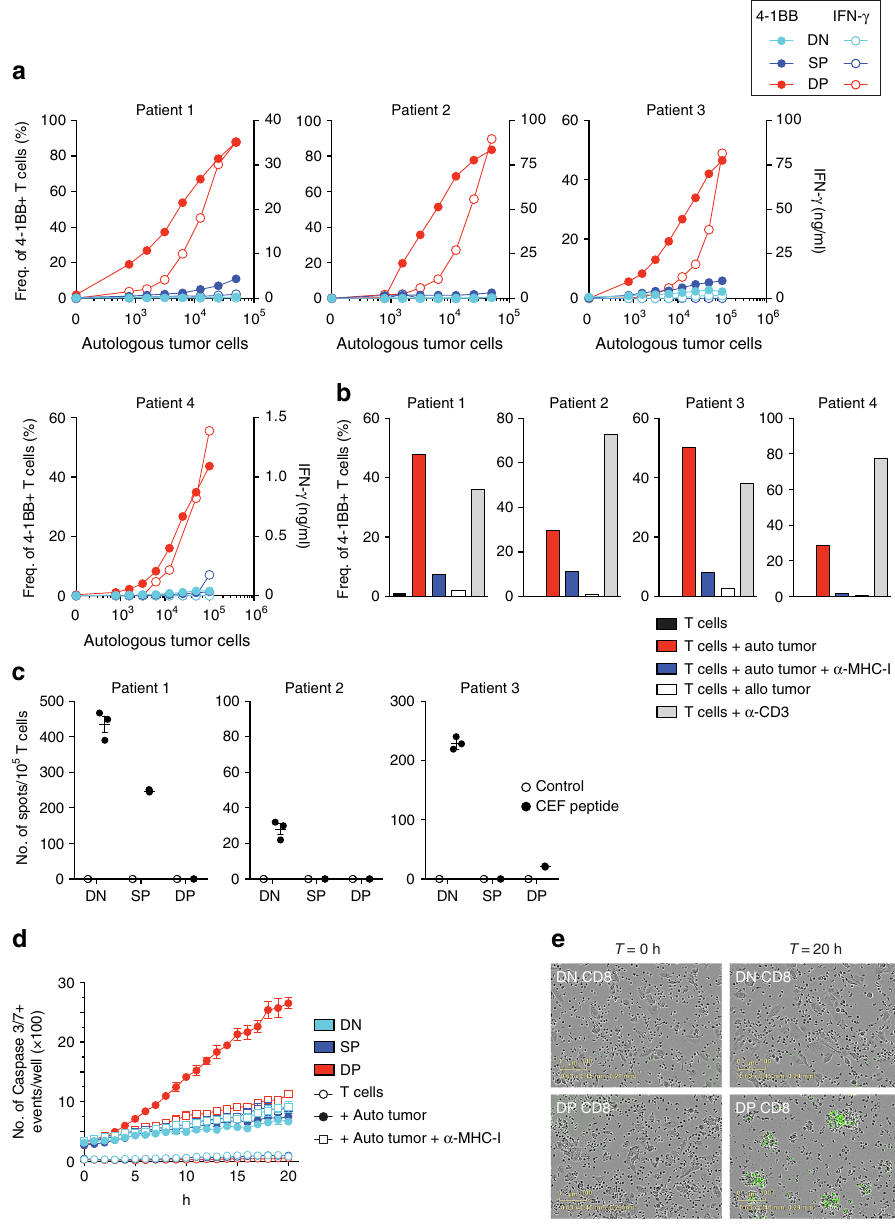
Fig. 6 DP CD8 TILs recognize and kill autologous tumor cells. DN, SP, and DP CD8 TILs were sorted from tumor digest and expanded in vitro. a Expanded CD8 TILs were tested for tumor reactivity by cultivating them for 20 h with increasing numbers of autologous tumor cells, and tumor recognition was assessed by measuring the frequency of 4-1BB expression ( fi lled symbols) and IFN- γ secretion (open symbols). Results are shown for four melanoma patients. b Reactivity of DP CD8 TILs was con fi rmed by culture with autologous tumor cells with and without MHC-I blocking antibody, allogeneic tumor cells, and plate-bound anti-CD3. The upregulation of 4-1BB after 20 h is shown for four melanoma patients. c The reactivity of expanded DN, SP, and DP CD8 TILs against a pool of 32 peptides derived from EBV, CMV, and in fl uenza virus was assessed by measuring IFN- γ secretion by ELISPOT. Experiments were performed in triplicate and results are shown for three melanoma patients. All TIL sub-populations showed similar levels of IFN- γ when stimulated with anti-CD3. d Expanded DN, SP, and DP CD8 TILs were cultured with and without autologous tumor cells, in presence and absence of MHC-I blocking antibody. Caspase 3/7 + events (green fl uorescence) were monitored every hour with the Incucyte live-cell imaging system over a 20 h period and analyzed as described in the Methods section. Small horizontal lines indicate the mean ± SEM. e Representative images for DN and DP CD8 T cells taken at the beginning ( T = 0) and at the end of the co-culture with autologous tumor cells ( T = 20 h). Green fl uorescence indicates caspase 3/7 activity. Results shown in d and e are representative of two